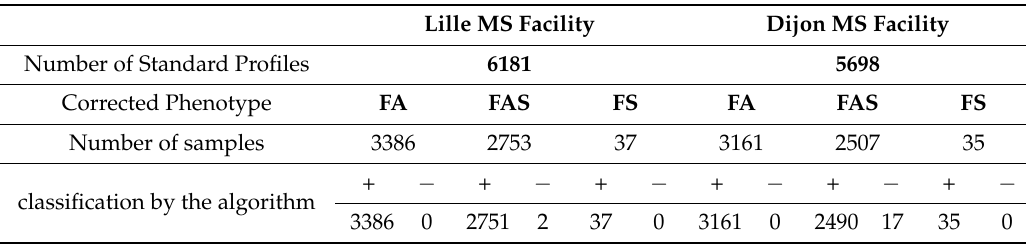
Table 2. The number of standard MS profiles correctly classified (+) or misclassified ( − ), according to the newborn’s corrected phenotype.